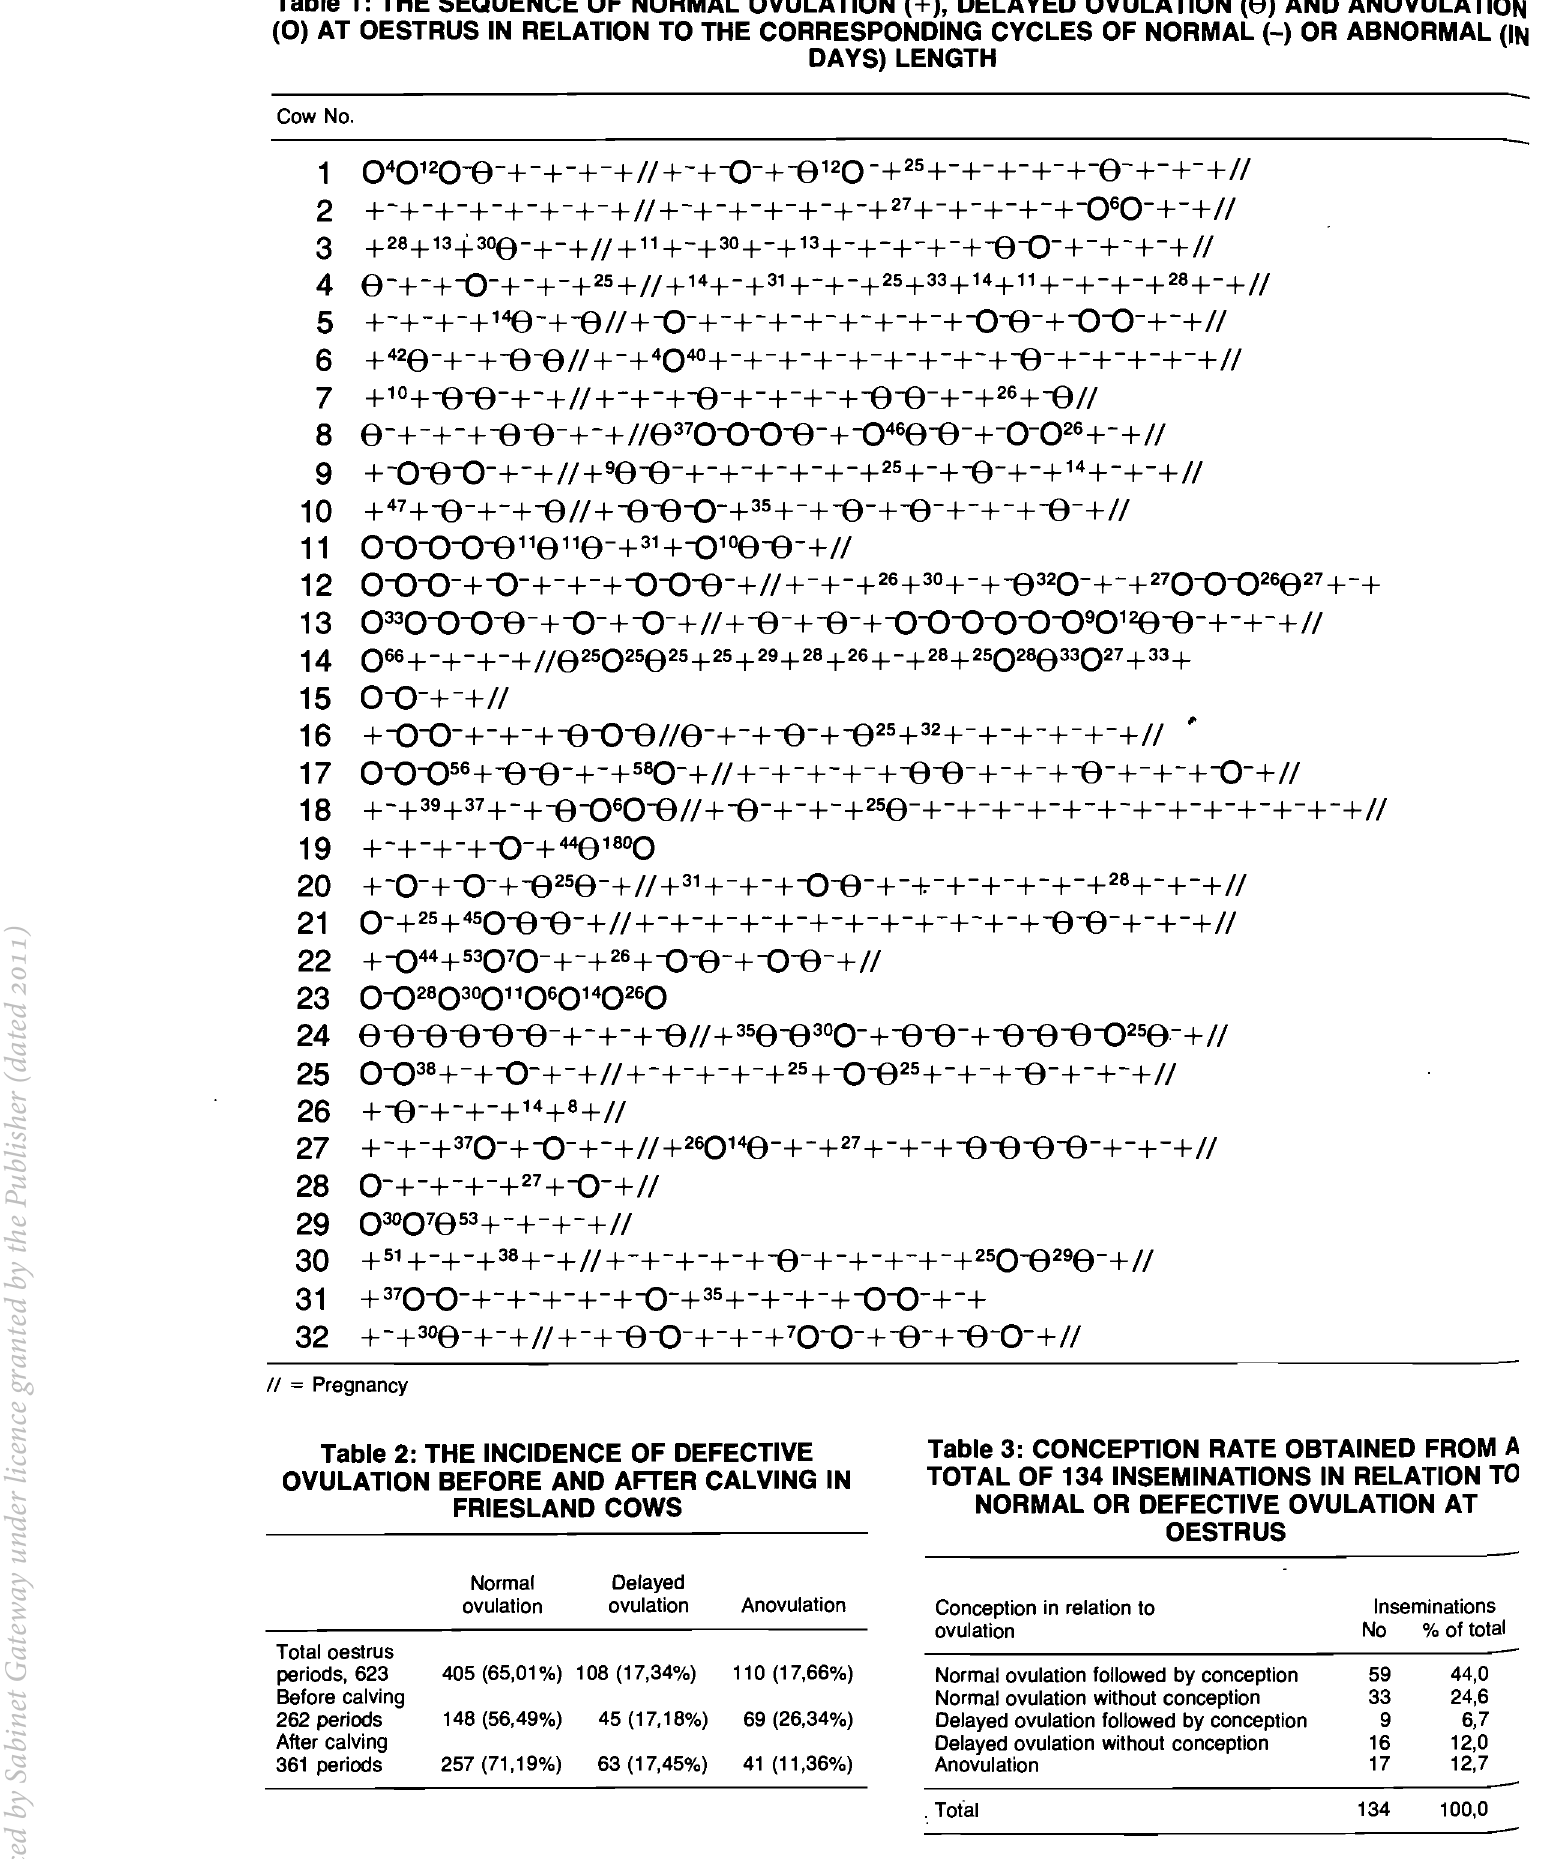
Table 2: THE INCIDENCE OF DEFECTIVE OVULATION BEFORE AND AFTER CALVING IN FRIESLAND COWS